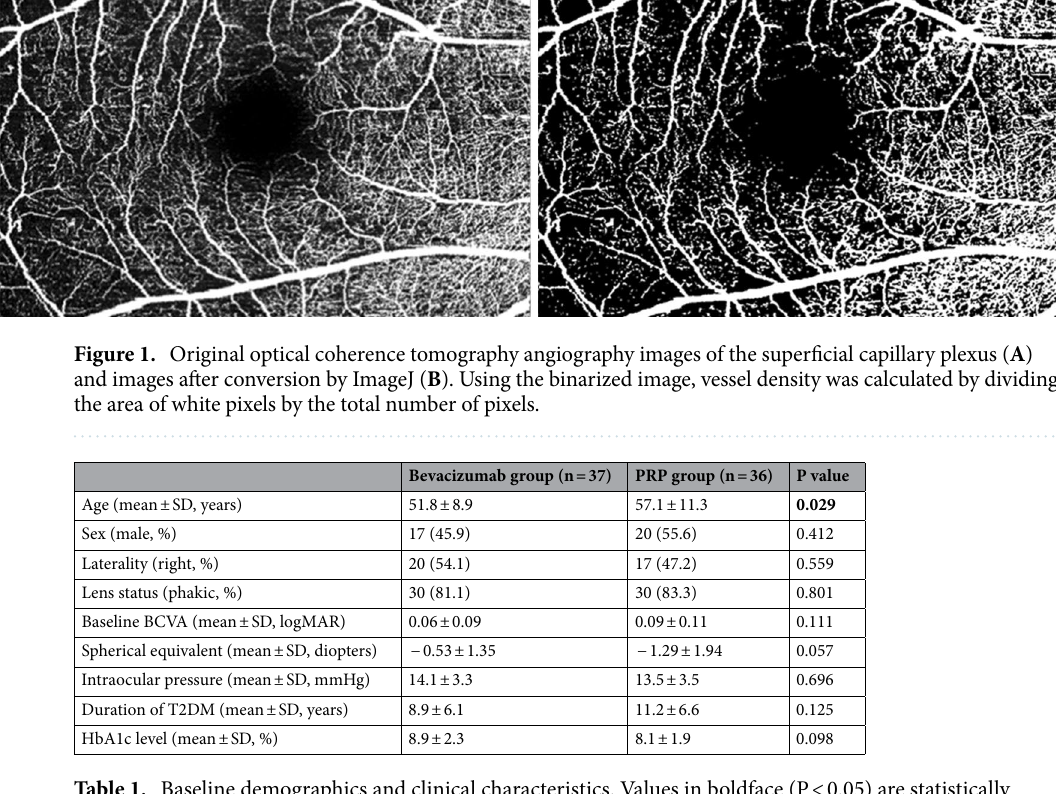
Table 1. Baseline demographics and clinical characteristics. Values in boldface (P < 0.05) are statistically significant. BCVA best-corrected visual acuity, T2DM type 2